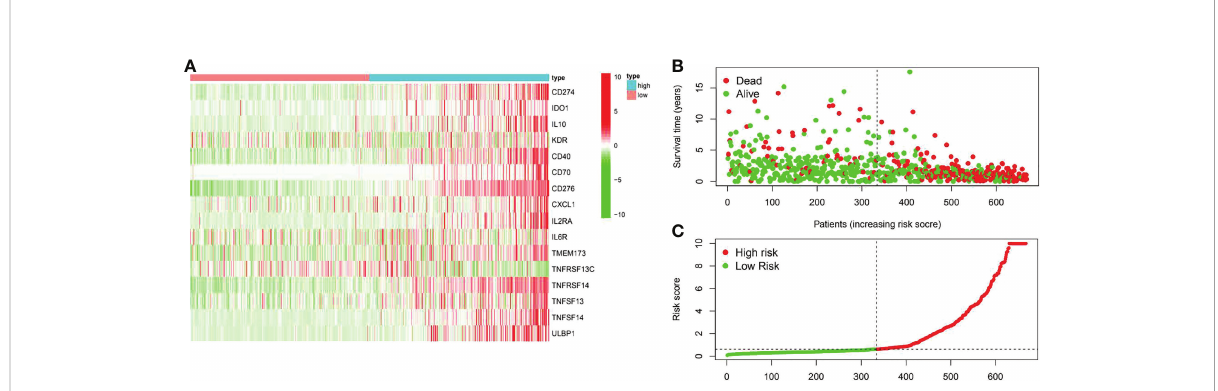
FIGURE 14 The prognostic value of the risk model of the 16 COL6A2 related immunostimulatory genes in the TCGA cohort. (A) The heatmap displayed the expression levels of COL6A2 related immunostimulatory genes in the high-risk and low-risk groups. (B) The scatterplot based on the survival status of each sample. The green and red dots represent survival and death, respectively. (C) The risk curve based on the risk score of each sample.